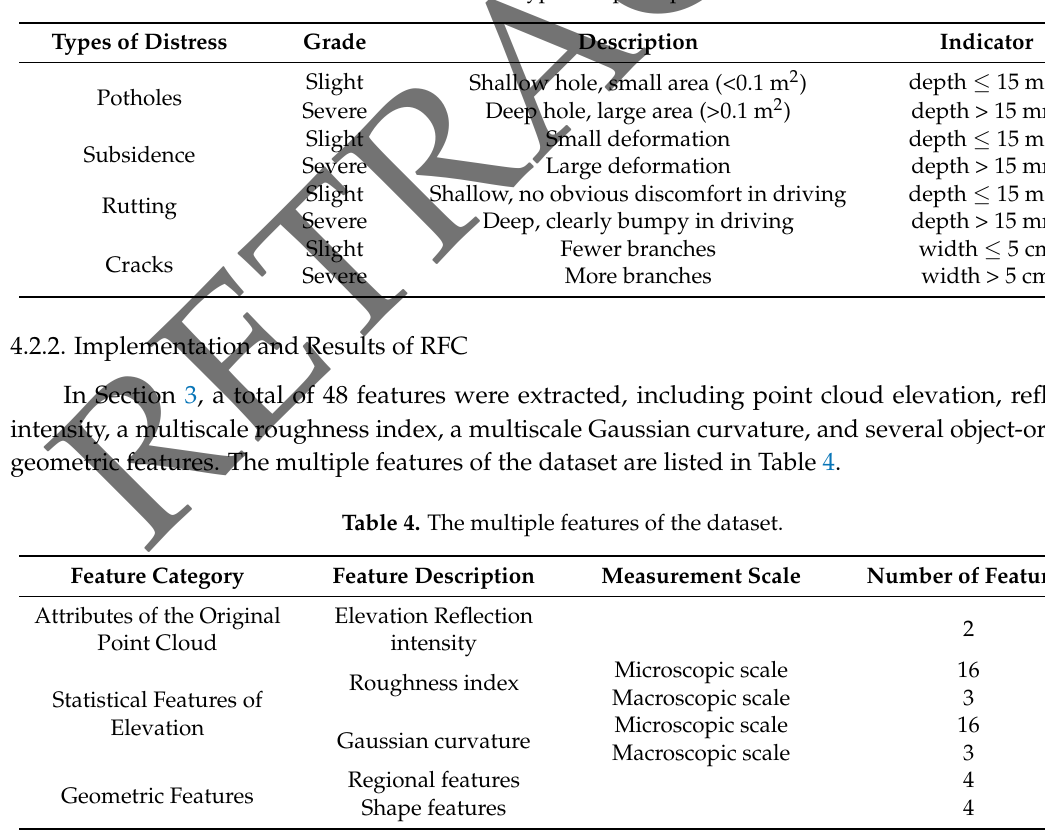
Table 3. Classification of typical asphalt pavement distress.